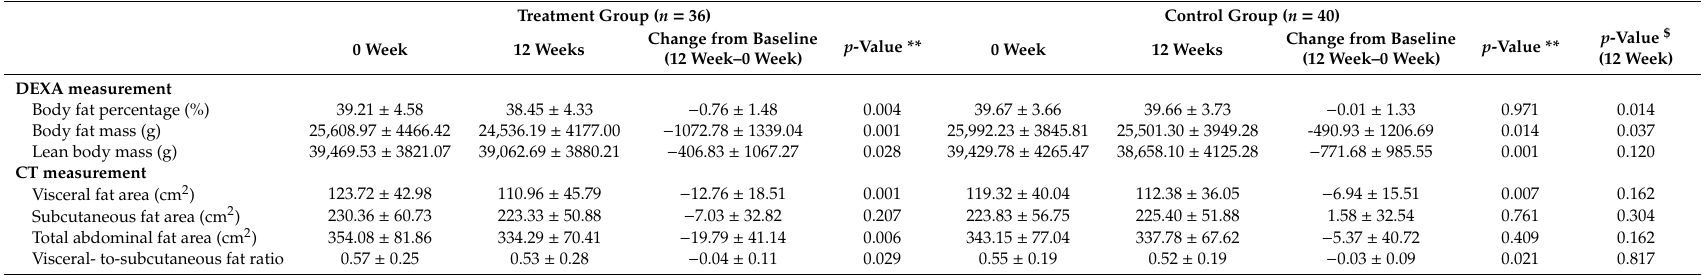
Table 2. E ffi cacy assessment by dual-energy X-ray absorptiometry (DEXA) and computed tomography (CT) measurement over the 0–12 weeks